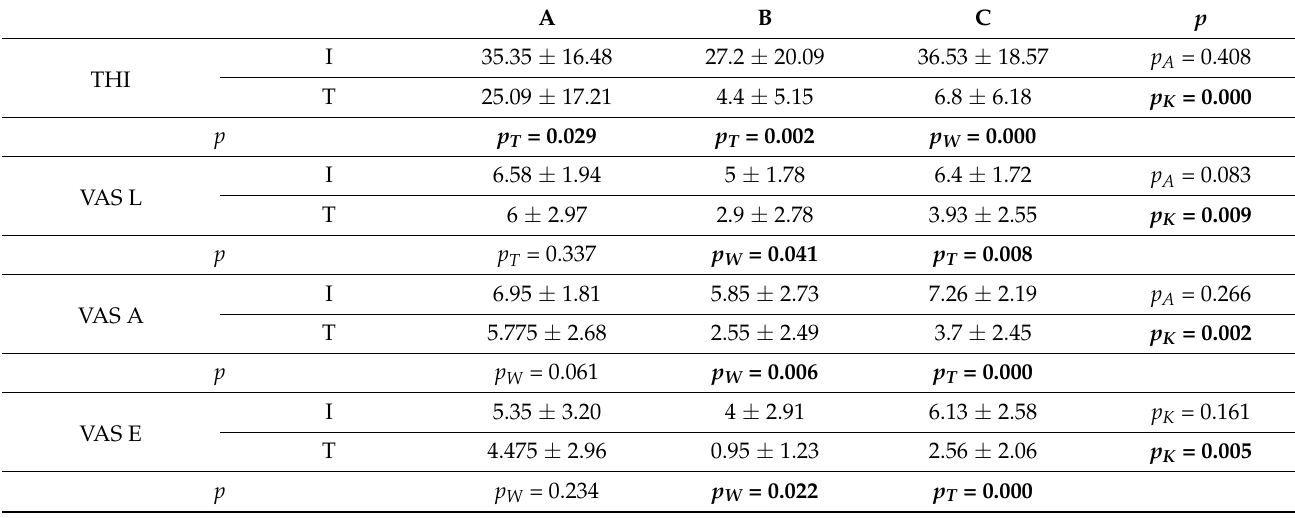
Group A, patients who were unsure about the effectiveness of TRT; group B, patients who were cured after the first counselling session; group C, patients who dropped out for other reasons; THI, Tinnitus Handicap Inventory; VAS, Visual Analogue Scale; L, loudness; A, annoyance; E, effect on life; I, initial; T, telephonic; p A , p value from one-way ANOVA; p K , p value from Kruskal–Wallis test; p W , p value from Wilcoxon test. p T , p value from paired t -test. p values in bold are statistically significant ( p <